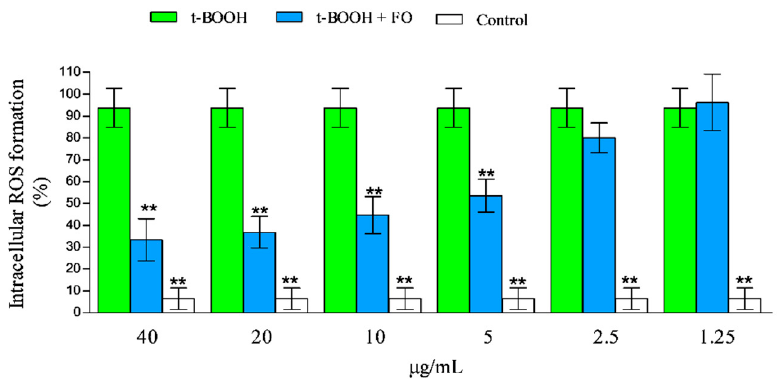
Figure 6. Effects of feijoia EO on t-BOOH-induced reactive oxygen species (ROS) production in erythrocytes. Intra-cellular ROS production was determined by DCF fluorescence. The asterisks (**) indicate significant differences ( p < 0.05) of the sample vs t-BOOH-treated one. Each value represents mean ± SD of three independent experiments ( n = 3).